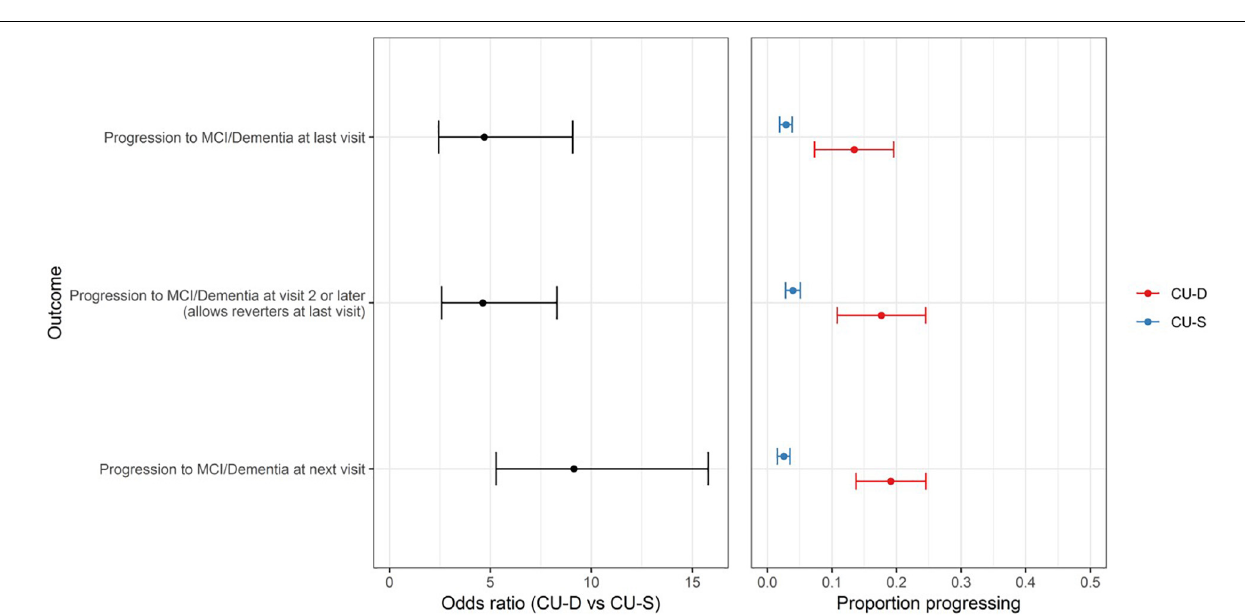
FIGURE 3 | Baseline cognitive status of CU-D predicts increased risk of progressing to MCI/Dementia at last assessment. Ln(odds ratios) and 95% CI’s from logistic regression model. CU-D, cognitive unimpaired-declining.